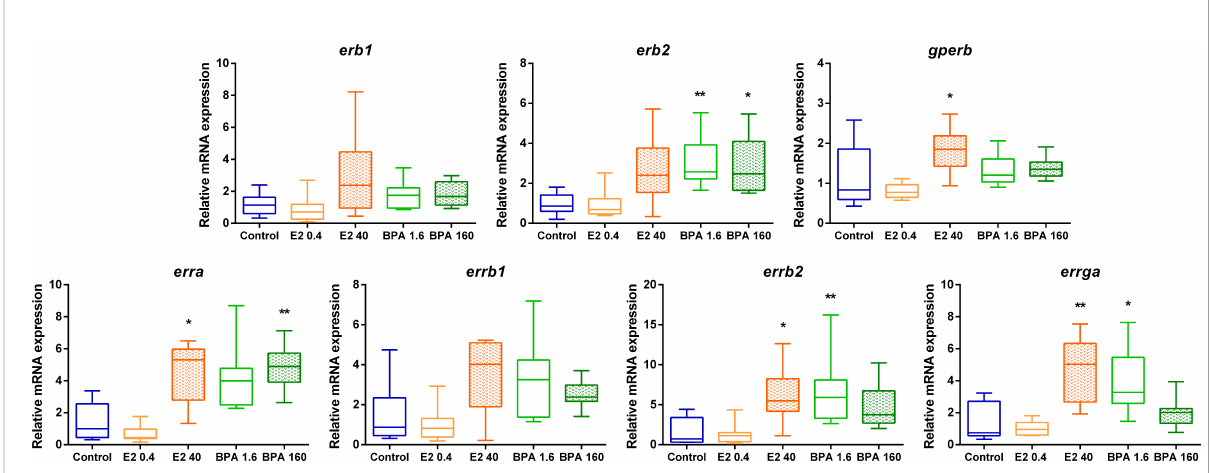
FIGURE 5 Relative mRNA expression of nuclear and membrane estrogen receptor genes and estrogen-related receptor genes in 16-dph individuals exposed for 4 days at nominal concentrations of E2 0.4 and 40 ng.L -1 , BPA 1.6 and 160 m g.L -1 , and ethanol 0.0008% (v/v) as a solvent control. Relative mRNA levels are expressed as DD Cp with solvent control as a reference (n=8-10 individuals). In boxplots, hinges indicate fi rst and third quartiles; whiskers indicate the min and max values, and horizontal lines indicate the median. Difference between treatments was tested using the non-parametric multiple comparison test Kruskal-Wallis, followed by Dunn ’ s post-hoc test. Black stars indicate signi fi cant differences compared to the solvent control (multiplicity adjusted p-value: *p < 0.05; **p <